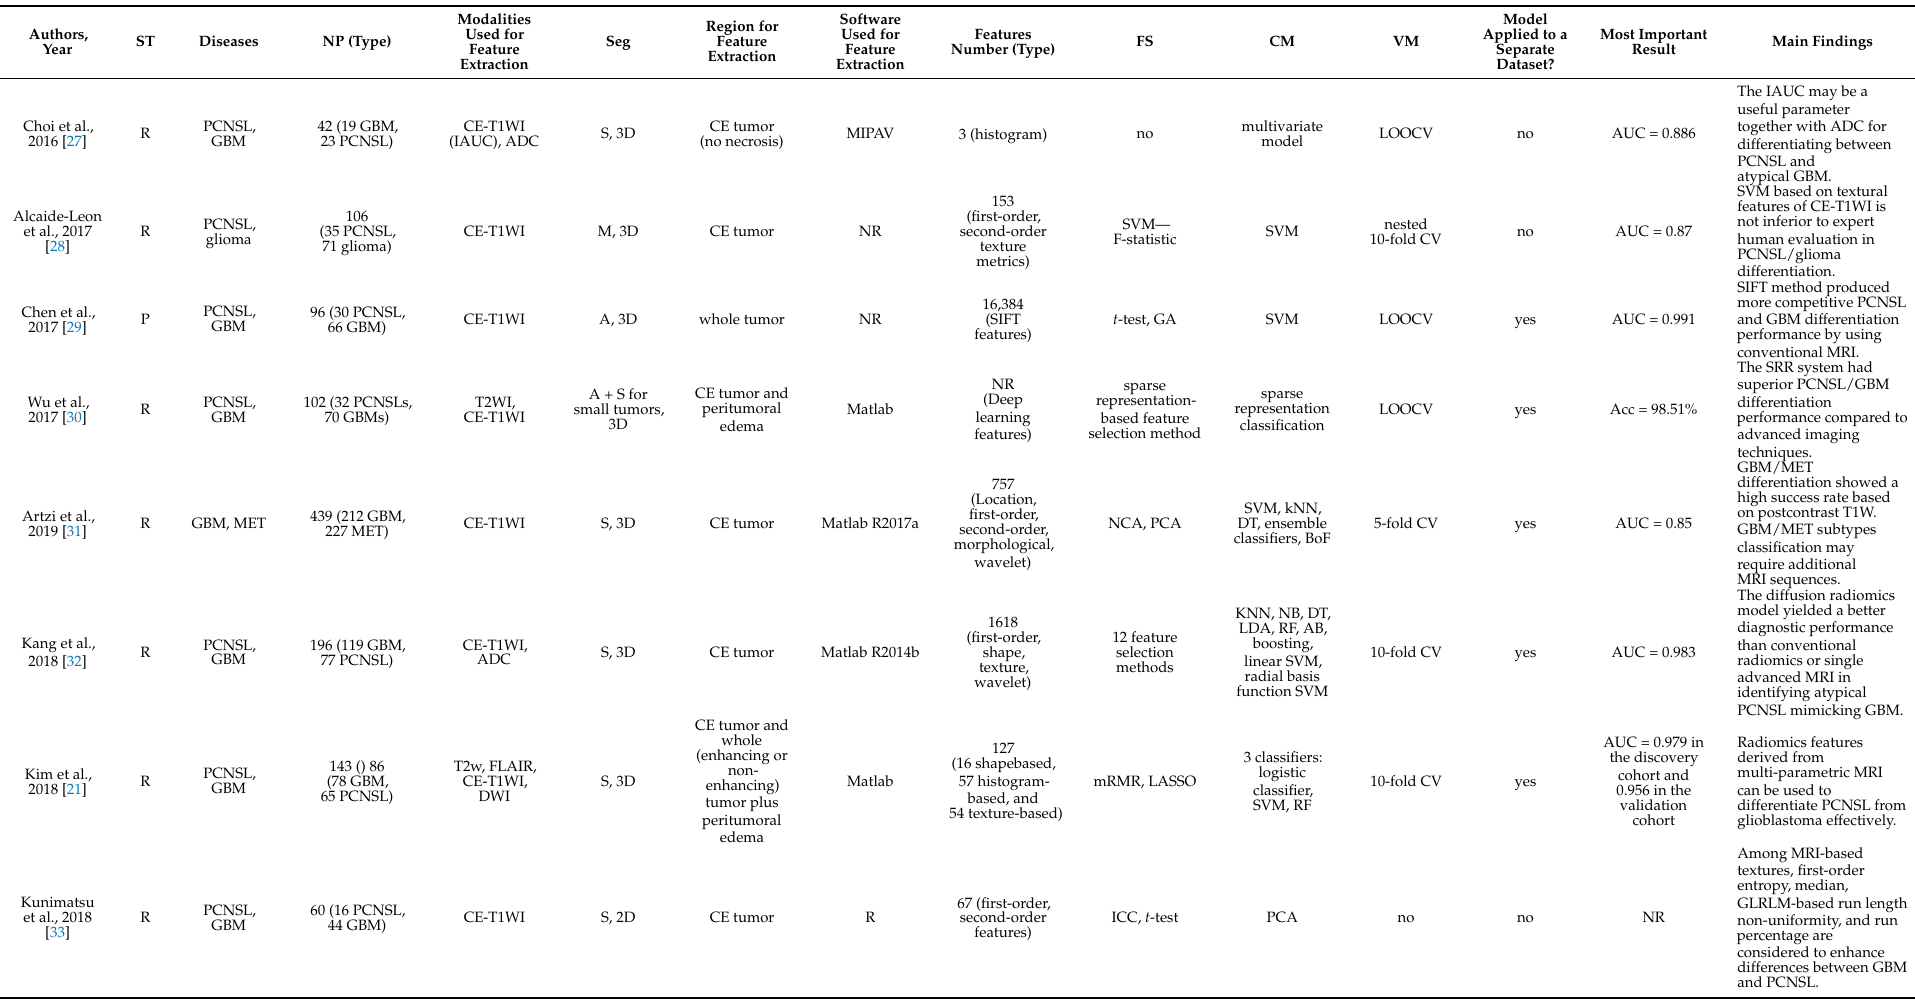
Table 1. Characteristics of included studies. Abbreviations: ST = Study Type; R = Retrospective; P = Prospective; NP = Number of Patients; Seg = Segmentation; FS = Feature Selection; CM = Classification Method; VM = Validation Method. See Supplementary Materials -Section S5- for additional abbreviations.